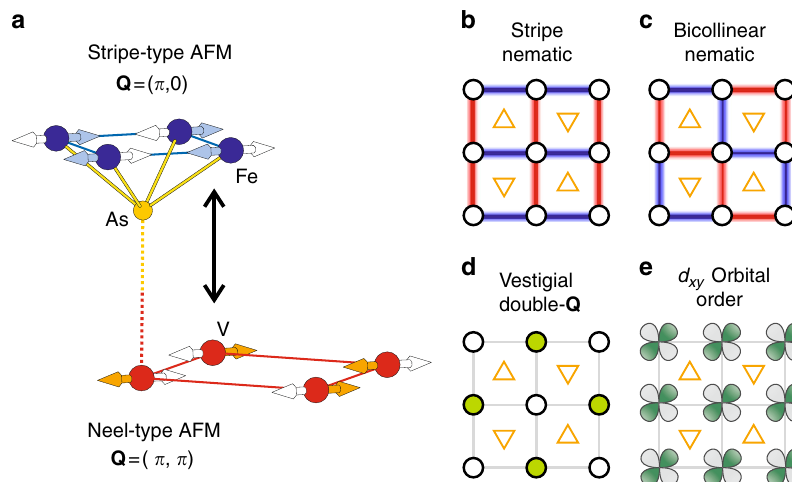
Fig. 4 Possible orders retaining a C 4 symmetry without long-range magnetism. a Stripe-type and Neel-type AFM fl uctuations of Fe and V spins, respectively, at high temperatures. Two arrows at each Fe and V sites illustrate fl uctuating moments with their own spin correlation, indicated by different colors. These different types of AFM fl uctuations are frustrated via Fe – V spin coupling (vertical arrow) developed at low temperatures. b – d Various vestigial ordered phases resulting from melting the corresponding magnetic orders: the typical stripe nematic ( x / y symmetry broken), the bicollinear nematic (( x + y )/( x − y ) and the translation symmetry broken) 36 , and the vestigial double- Q phase (only the translational symmetry broken) 37 . e d xy orbital order driven by a possible orbital-selective Mott transition. As opposed to b – d , there is no symmetry breaking at all in this phase compared to the high- temperature phase. In b and c , the symmetry breaks because some bonds are predominantly ferromagnetic (red) and some predominantly antiferromagnetic (blue). In d , green circles indicate completely nonmagnetic Fe sites, while open circles correspond to fl uctuation paramagnetic sites. The As sites above (up-triangle) and below (down-triangle) the Fe plane are also shown. Note that only d and e are consistent with the observed C 4 symmetry, as discussed in the main text, and are our favorite candidates for the hidden order below T